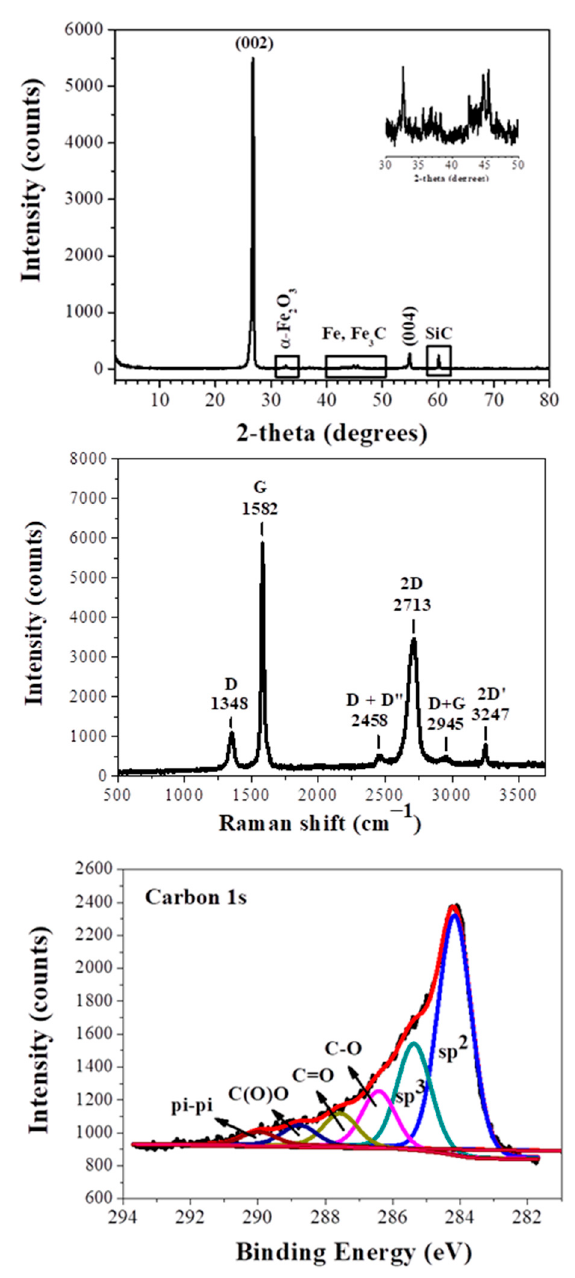
Figure 1. XRD pattern ( top ), Raman spectrum ( middle ), and C1s XPS spectrum ( bottom ) of the synthetic graphite. The top inset shows in magnification the 2-theta region 30–50°.